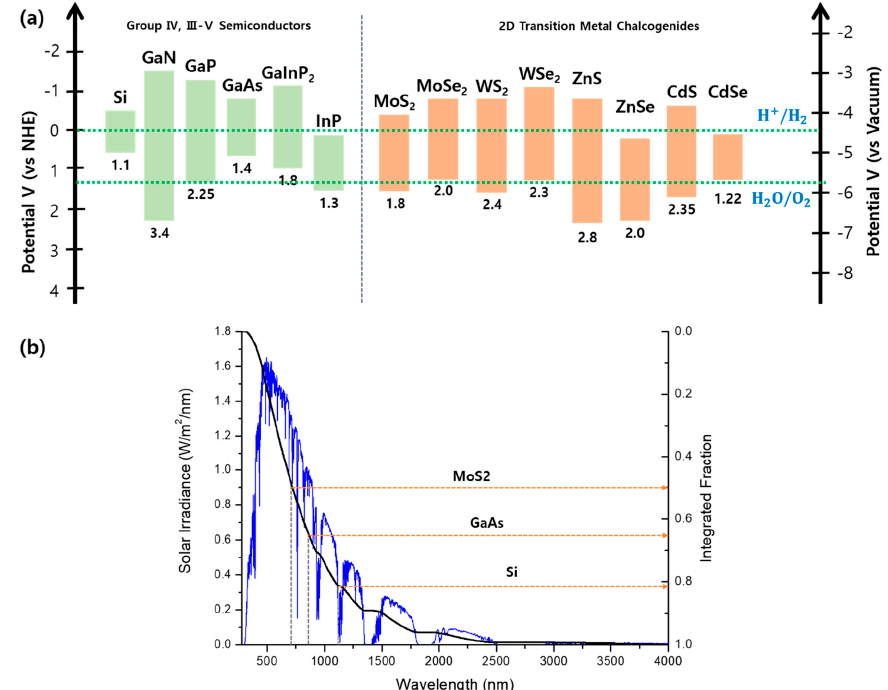
Figure 1. ( a ) Bandgaps and band edge positions of group IV, III-V semiconductors (green) and transition metal chalcogenides semiconductors (orange) relative to the hydrogen evolution reaction (HER) and oxygen evolution reaction (OER) active potentials (bulk band gaps corresponding to each are indicated in the dotted line below). ( b ) Solar irradiance spectrum of air mass (AM) 1.5 G for a 37 ◦ tilted surface. The ratio of absorbed solar light irradiance is integrated and is shown on the right-side y-axis of the graph (the blue line represents the irradiance unit of wavelength under 1 sun, and the black line represents the accumulated solar irradiance starting wavelength of 280